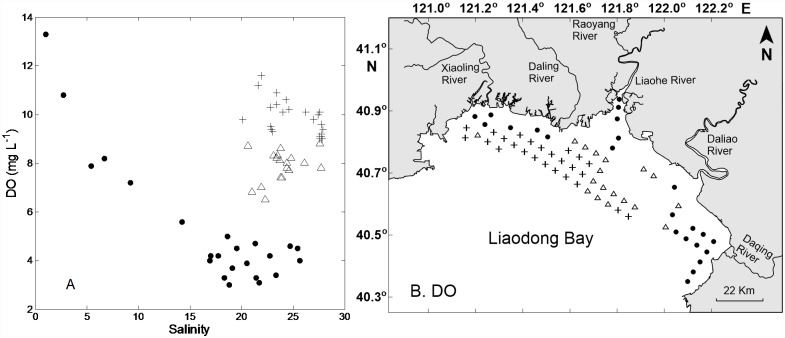
Relationship between DO concentrations and salinity (Panel A) and location of stations in three groups with different DO concentrations (Panel B).In Panels A and B, circle dots denote stations with high DO of more than 13 mg L–1 at a salinity of 1 to low DO concentrations of 3–5 mg L–1 at salinities of 16–26; Triangles and plus signs denote stations with DO concentrations of roughly 7–9 mg L–1 and 9–11 mg L–1, respectively, in both cases at salinities of 20–28.